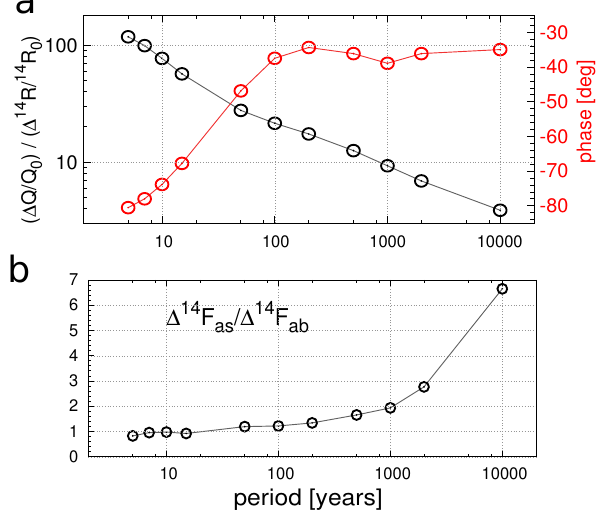
Fig. 5. Response of the Bern3D-LPJ model to periodic sinusoidal variations in the atmospheric radiocarbon ratio ( 14 R ) with an ampli- tude of 10‰ (in units of 1 14 C). (a) Relative change in production rate, Q , divided by the relative change in 14 R (with respect to a PI steady state; black) and the phase shift between Q and 14 R (red, left axis); Q is always leading atmospheric 14 R . (b) Relative changes in the net atmosphere-to-sea ( F as ) and the net atmosphere-to-land biosphere ( F ab ) fluxes of 14 C for the same